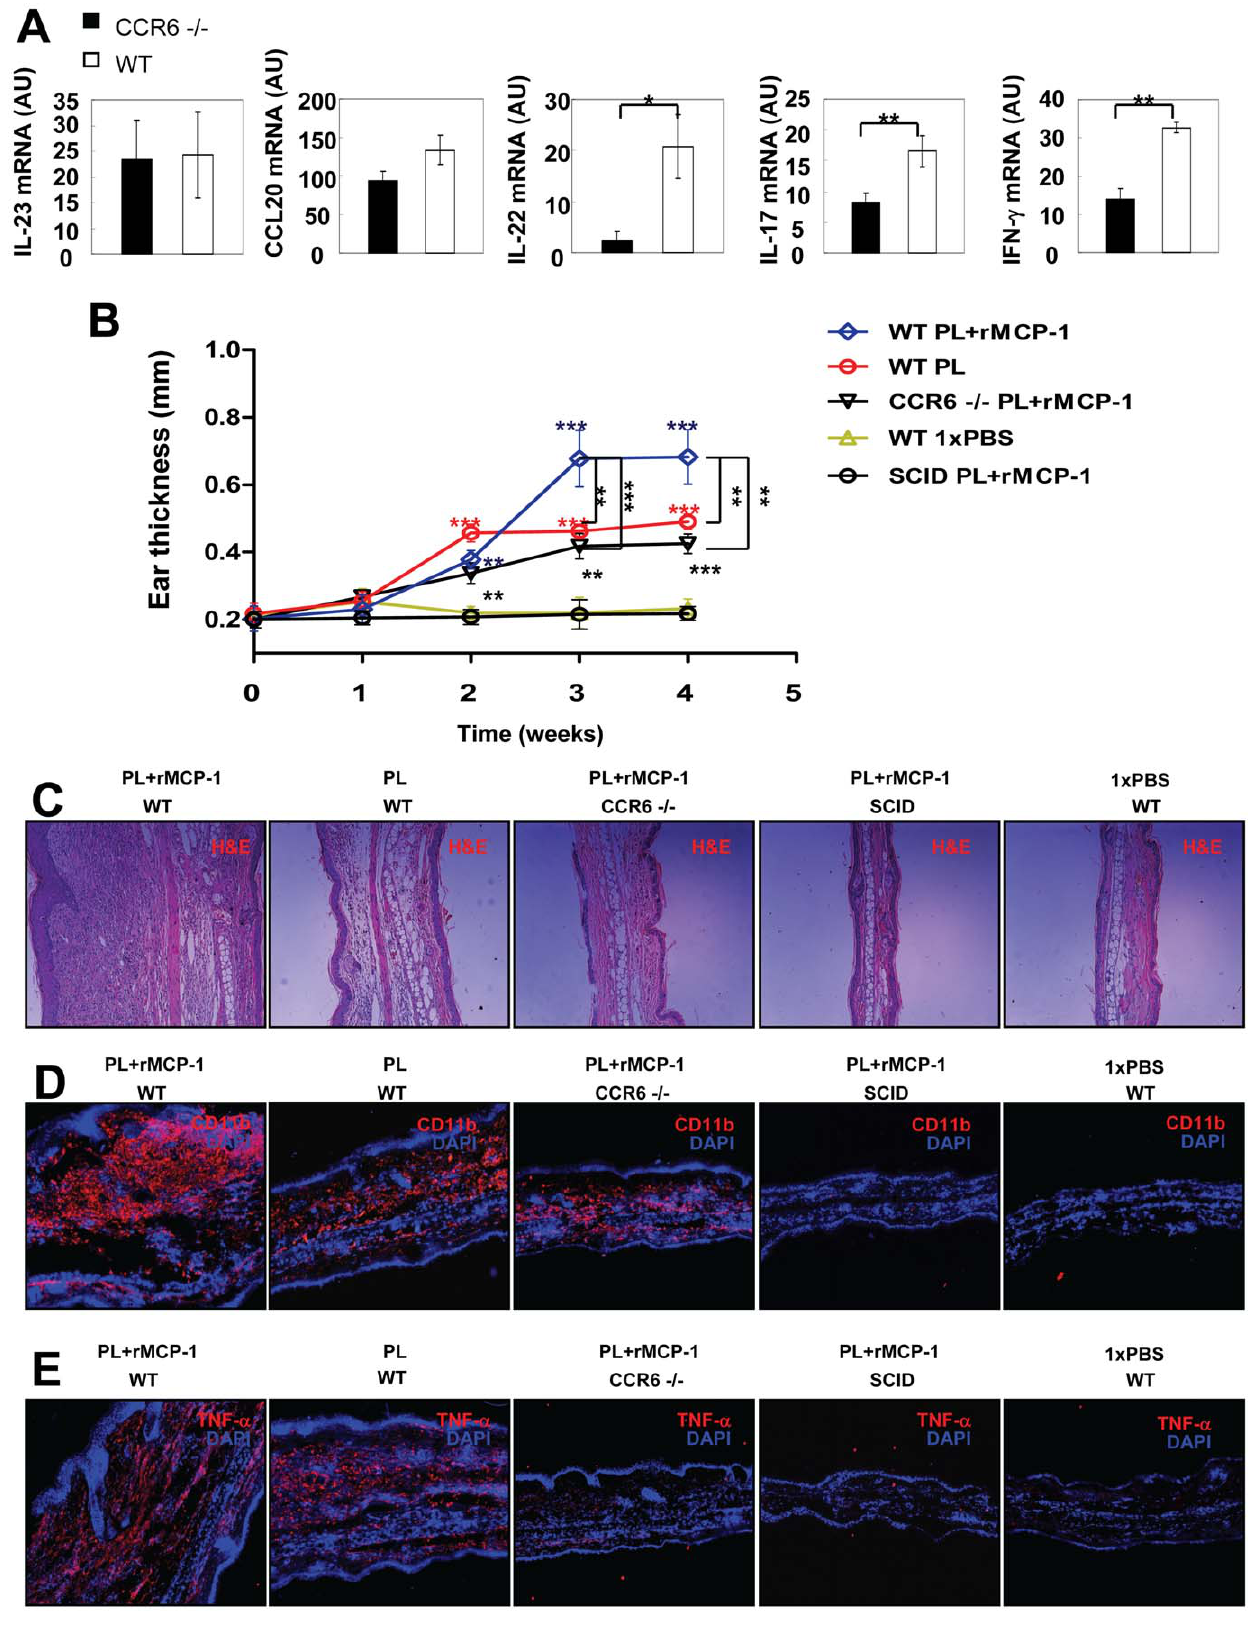
Figure 4. Requirement for CCR6 + T cells in the development of PL-induced psoriasiform skin changes. The ears of CCR6 2 / 2 and WT C57BL/6J mice were injected intradermally with different treatment. ( A ) Real-time PCR analysis of IL-23, CCL20, IL-22, IL-17A and IFN- c transcripts six hours after injection. ( B ) Ear thickness of mice with indicated genotypes or treatments was measured before and at multiple time points after